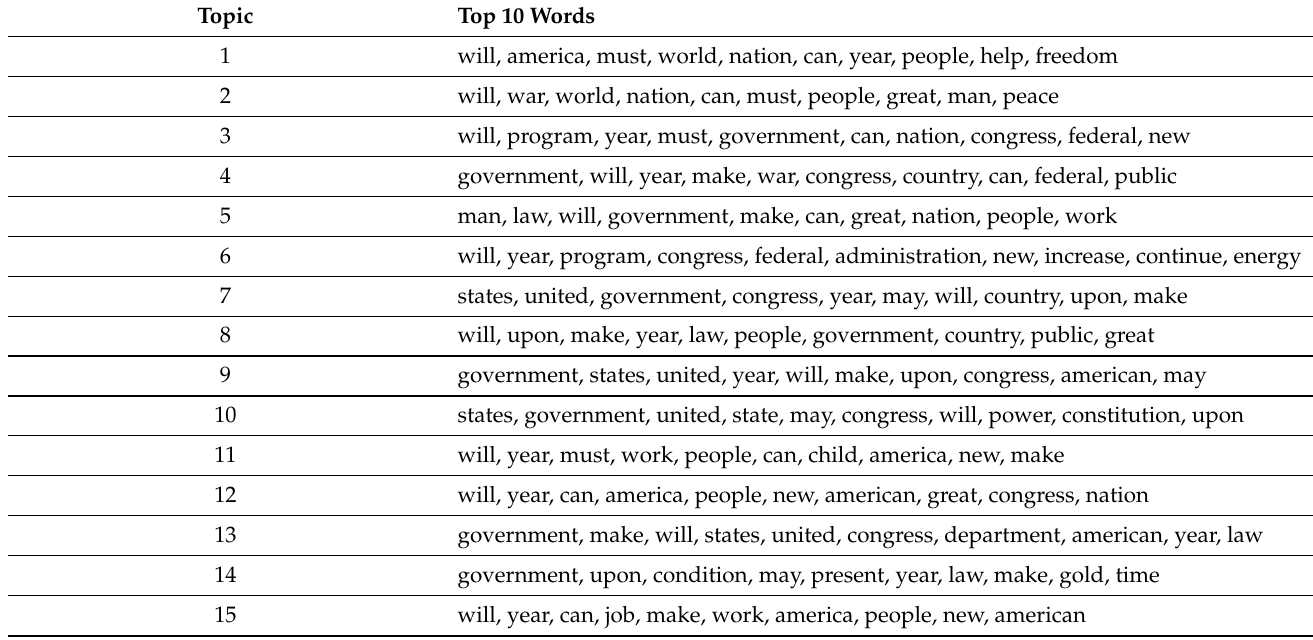
Table 3. Top 10 words from an estimated plain LDA with 15